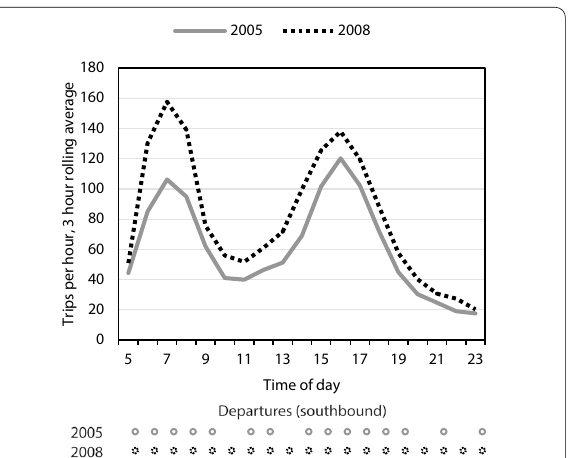
Fig. 3 Centred three‑hour rolling average of trips per hour on Råådalsbanan (case A) on a typical weekday in 2005 and 2008. The circles below the chart represent departure